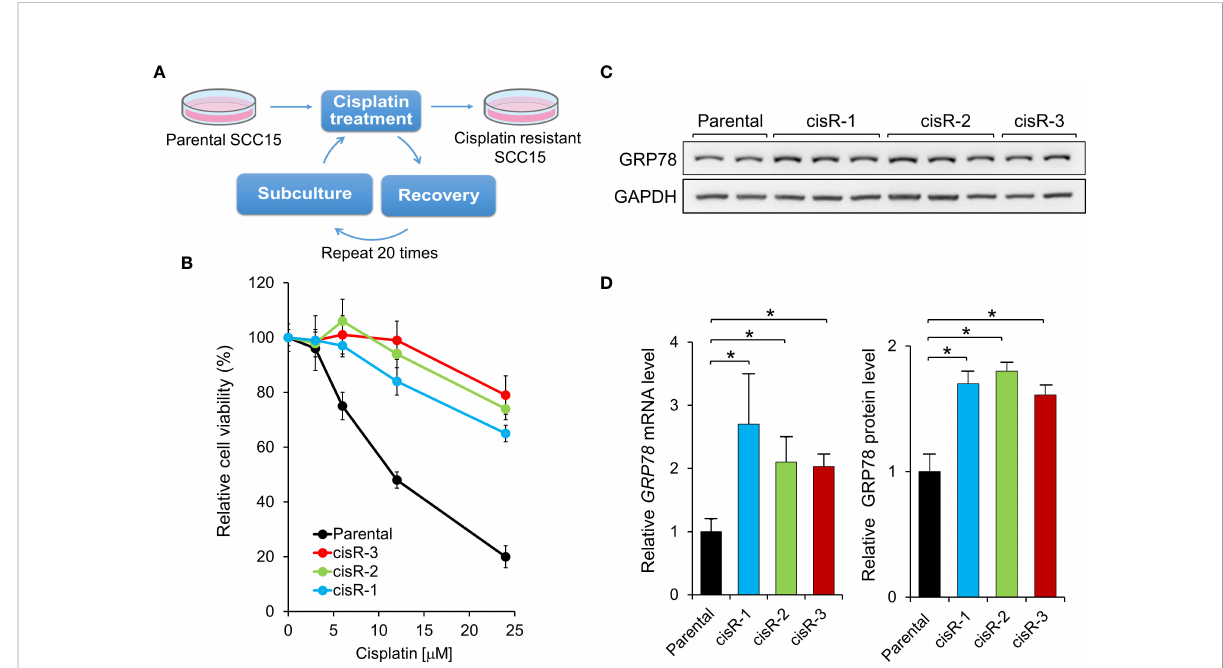
FIGURE 5 Generation of cisplatin-resistant HNSCC cell lines. (A) Schematic drawing for establishing cisplatin-resistant SCC15 cells. The cells were treated step-wise with increasing doses of cisplatin for 48 hr followed by recovery for at least 1 week. Three cisplatin-resistant cell lines, cisR-1, cisR-2, and cisR-3, were generated. (B) Parental and the three cisplatin-resistant clones were treated with increasing doses of cisplatin for 48 hr and cell viability was measured by WST-1 assay. (C) GRP78 protein expression level was determined by Western blot analysis with GAPDH serving as loading control. (D) Left panel: GRP78 mRNA expression level was determined by quantitative RT-PCR after normalization against b -actin mRNA. Right panel: Quantitation of GRP78 protein levels in (C) after normalization against GAPDH. Data are presented as means ± S.D. (n=3). * P ≤ 0.05 (Student ’ s t